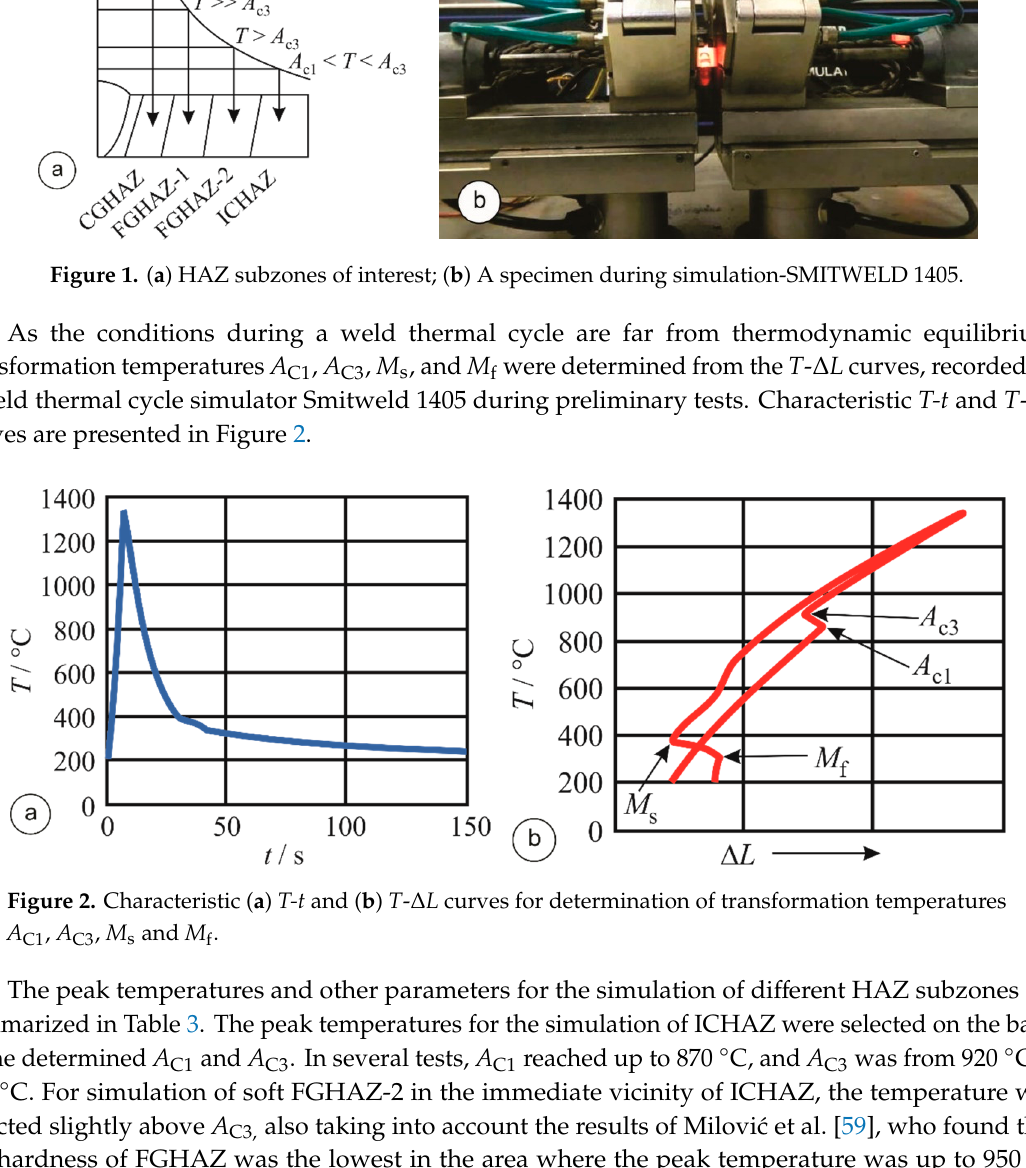
Figure 1. ( a ) HAZ subzones of interest; ( b ) A specimen during simulation-SMITWELD 1405.